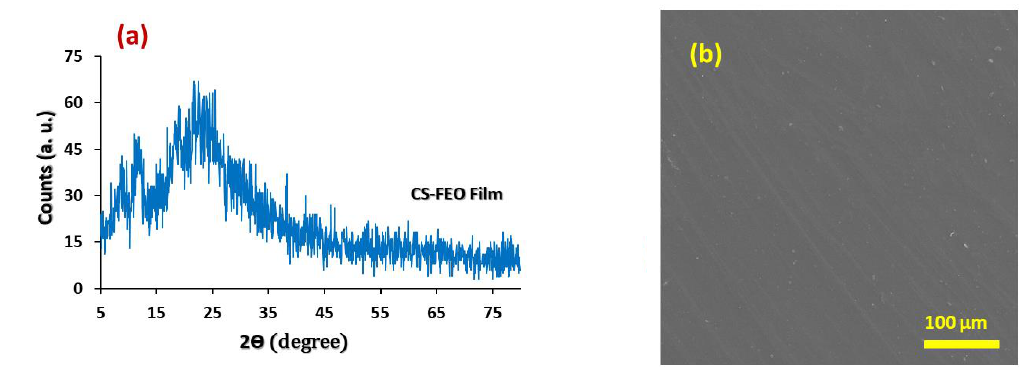
Fig.7:(a) XRD pattern and (b) FESEM image of the surface of the CS-FEO biopolymer.